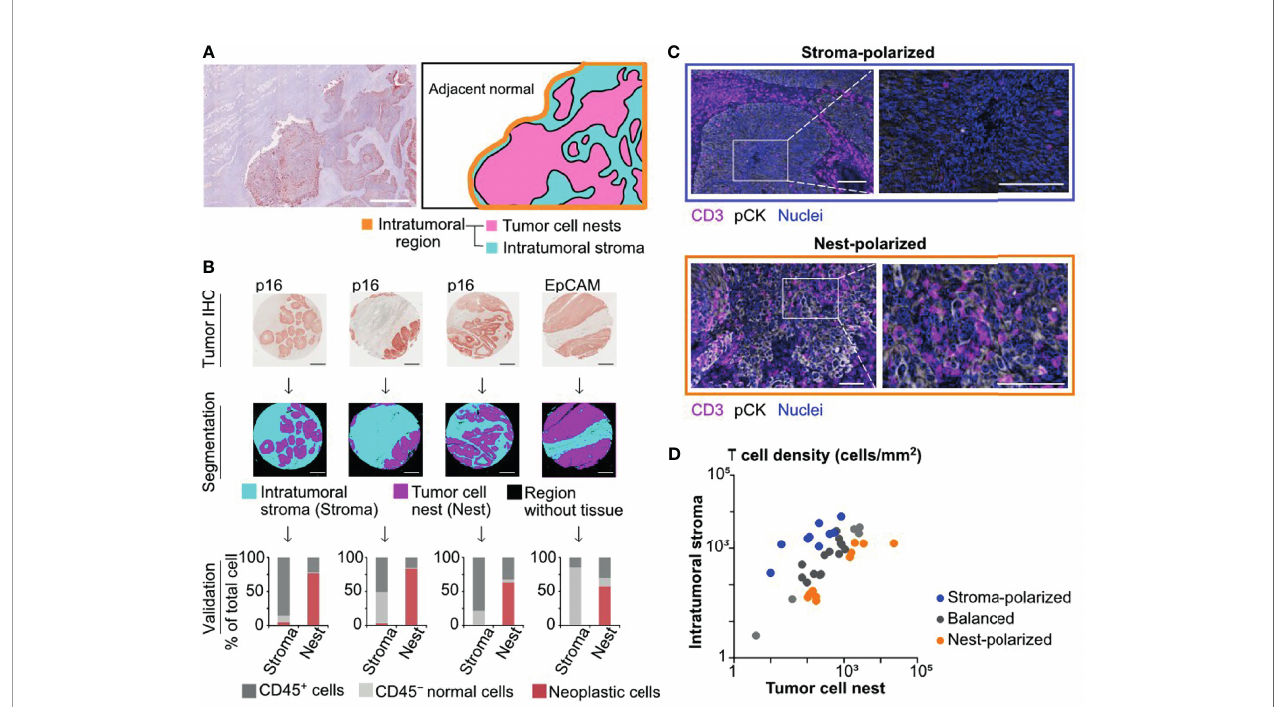
FIGURE 1 | Semi-automated tissue segmentation dissecting intratumoral regions reveals differential degrees of tumor cell nest-in fi ltration of T cells. (A) A superimposed image of hematoxylin and pan-cytokeratin (pCK) staining (left) depicts a representative tissue structure of oropharyngeal head and neck squamous cell carcinoma (SCC). A schematic diagram (right) presents different regions in the intratumoral area that is divided into tumor cell nests and the intratumoral stroma. Scale bar = 500 m m. (B) Tumor cell marker IHC images (p16 for HPV-positive, and EpCAM for HPV/p16-negative head and neck squamous cell carcinoma (HNSCC); see Materials and Methods ) (top) were utilized for semi-automated tissue segmentation classifying into tumor cell nest (Nest), intratumoral stroma (Stroma), and blank regions (middle). Percentages of CD45 + , CD45 − tumor cell marker − , and tumor cell marker + cells were analyzed by image cytometry, validating categorization of tumor cells into tumor nest regions (bottom). (C) IHC images present differential distributions of T cells (CD3 + ) within tumor cell nests (pCK + ) and the intratumoral stroma. Scale bars = 100 m m. (D) A correlation of T cell densities between the intratumoral stroma and tumor cell nests was shown in cases of oropharyngeal SCC (N = 38). The X and Y axes are shown on a logarithmic scale. Based on the cell density ratios of tumor cell nests to the intratumoral stroma, the polarization status was identi fi ed as nest-polarized (>2.0), stroma-polarized (<0.5), and balanced (0.5 –